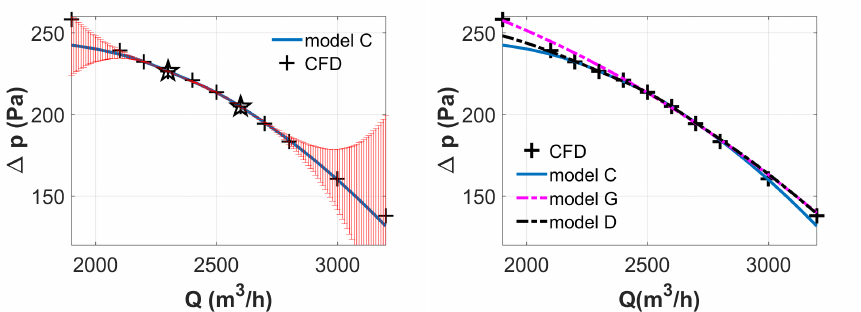
Figure 7. Comparisons among models C, G and D: ∆ p -Q. γ m = 0.